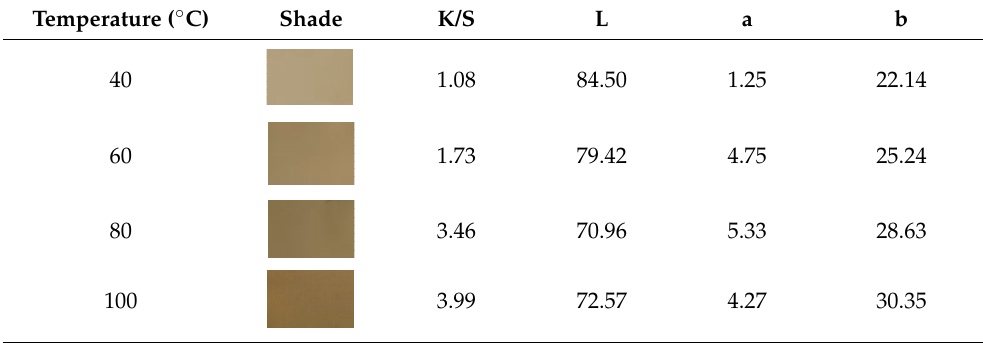
Table 3. Shades and colorimetric data obtained for the dyed polyamide fabrics at different dyeing temperatures.